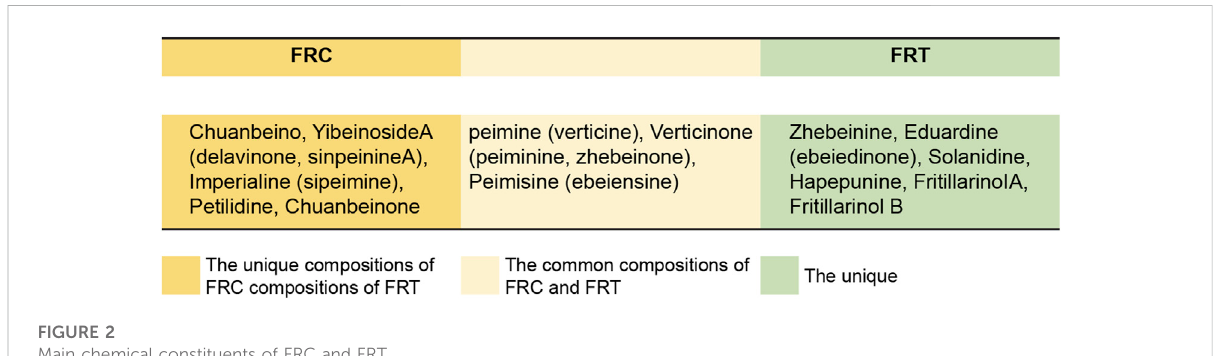
FIGURE 2 Main chemical constituents of FRC and